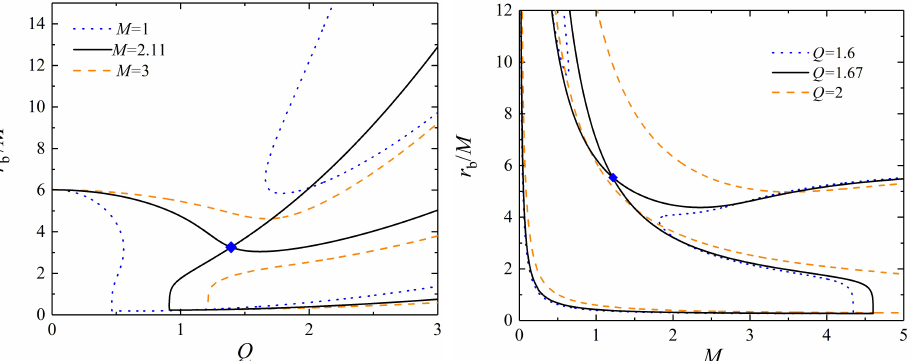
(+) ( − ) , U and U 2 type, respectively. 1 1